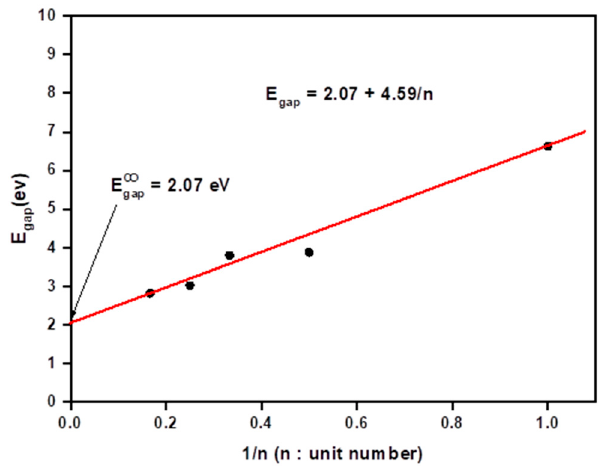
Figure 12. Variation of gap energy by unit number of the monomer ATT.